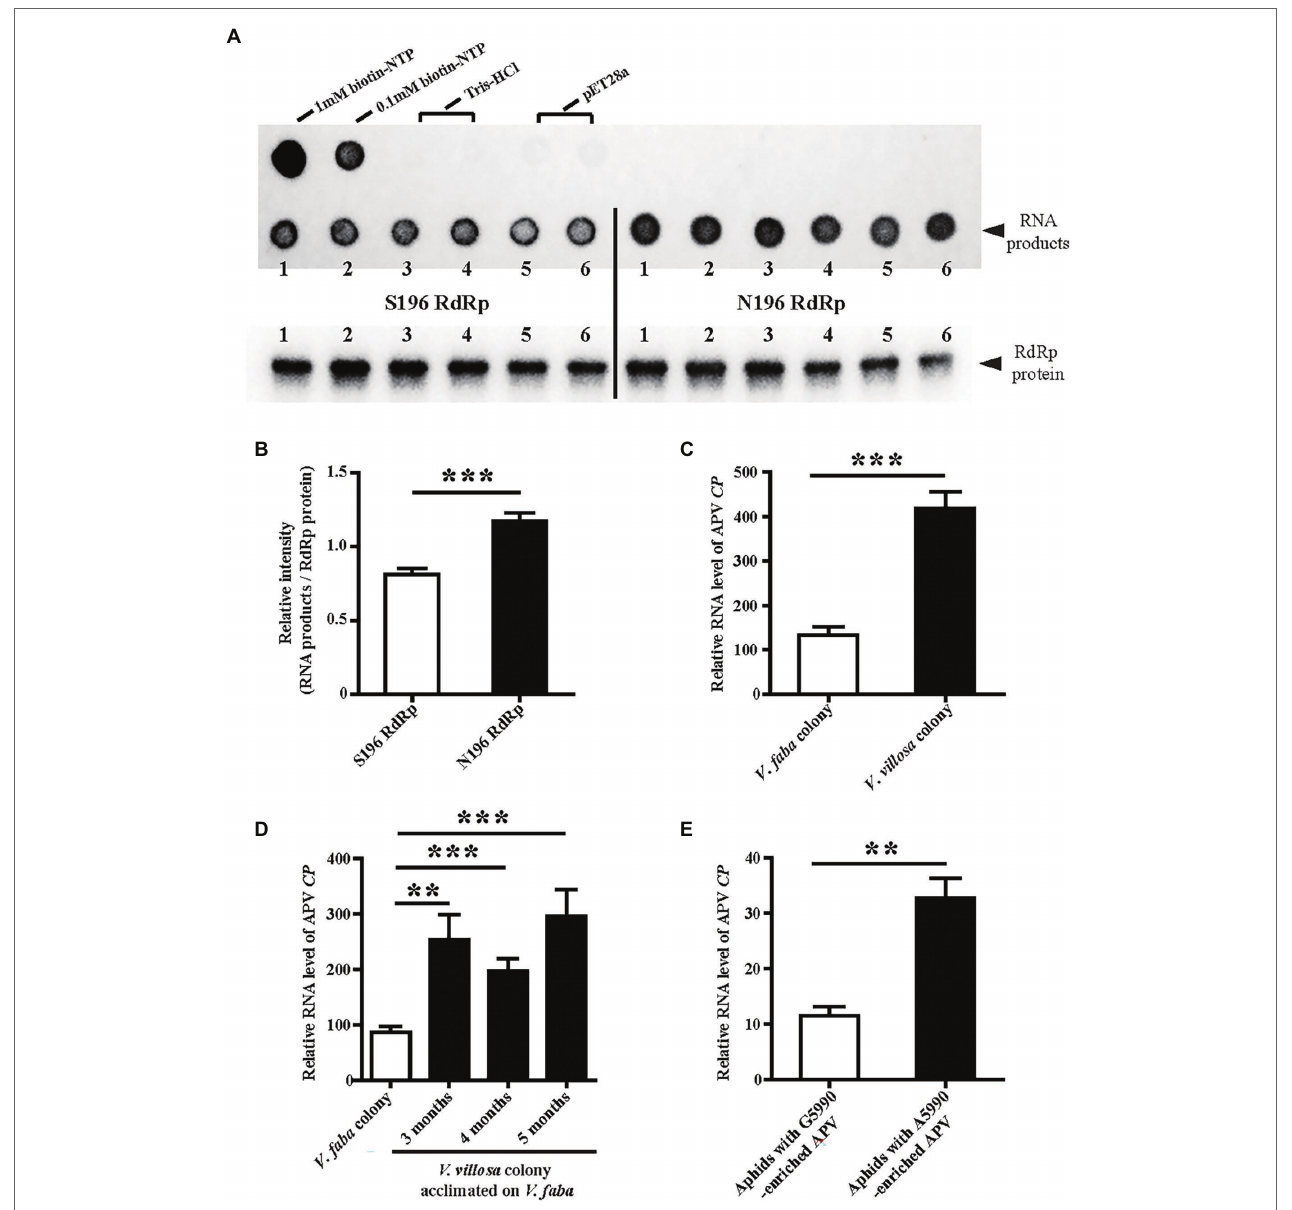
FIGURE 4 | Effects of SNP at site 5,990 on the enzymatic activity of APV RdRp and viral replication levels. (A) Dot blots showing the biotin-labeled RNA products synthesized by the recombinantly expressed S196-type RdRp-His and N196-type RdRp-His. The 1 and 0.1 mM biotin-NTP were used as positive controls. One hundred micrograms of crude protein from the cells transformed with pET28a vector and 20 mM Tris–HCl (pH 8.0) buffer were used as negative controls. The RdRp-His proteins used in the assays were measured by western blotting with an anti-His monoclonal antibody. Six replicates were prepared. (B) The relative intensity of synthesized RNA products to that of RdRp-His from (A) quantified with ImageJ software. The values represent the means ± SEs. (C) Comparison of the relative RNA levels of APV CP between the V. faba colony and V. villosa colony. Five to six biological replicates were prepared. (D) Comparison of the relative RNA levels of APV CP in the V. villosa colony that was acclimated on V. faba for 3–5 months. Thirteen to nineteen individual aphids were measured. (E) Comparison of the relative RNA levels of APV CP in the aphids 8 days post-infection with the A5990-enriched APV and the G5990-enriched APV. Nine biological replicates were prepared. The relative RNA level of APV CP to the transcript level of L27 is represented as the mean ± SE. Differences were analyzed using Student’s t test. ** p < 0.01; *** p <